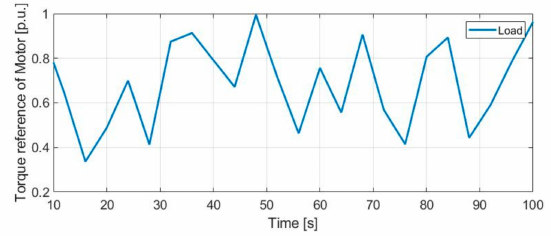
Figure 13. Load variation (p.u.) profile for Case 4.